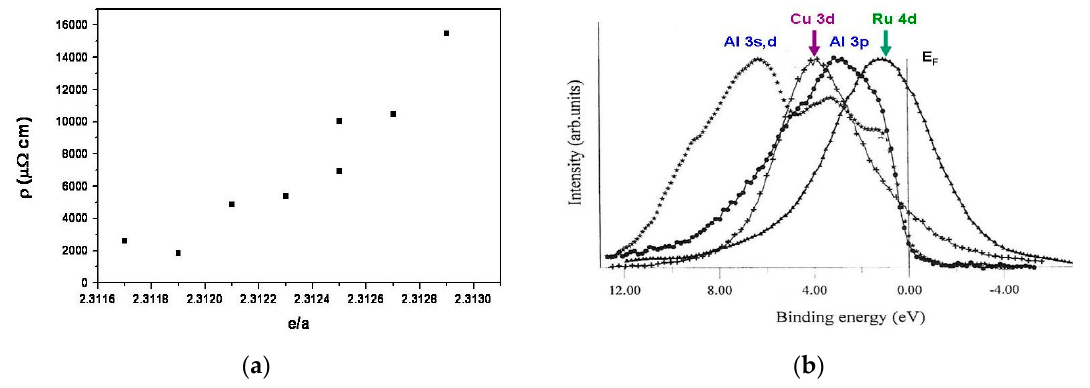
Figure 9. ( a ) Room temperature electronic resistivity values retrieved from the literature [14,76,77] as a function of the e/a ratio for i-Al ₆₅ Cu 35-x Ru x QCs. ( b ) Occupied state distribution in i-Al 65 Cu 20 Ru 15 : Al 3p (dotted line), Al 3s,d (starred line), Cu 3d (line with crosses), and Ru 4d (line with triangles) (courtesy Esther Belin-Ferré).